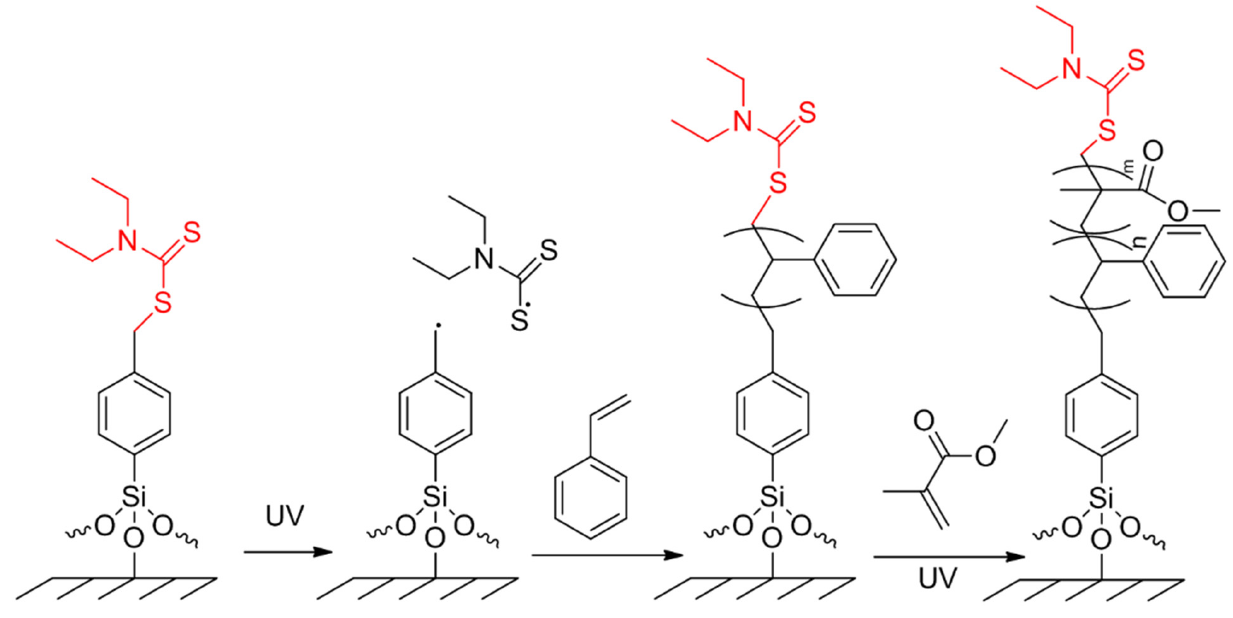
Figure 9. Exemplary preparation of copolymer brushes by SI-PIMP from a benzyl-N,N-diethyldithiocarbamate derivatized substrate (photosensitive group is labeled in red) [4,114].